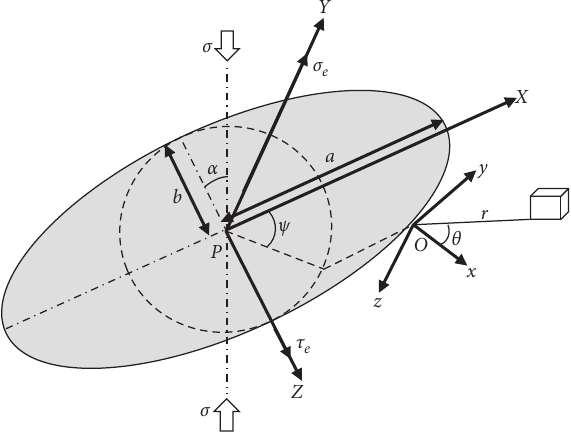
Figure 5: The 3D coordinate diagram of elliptic crack. Table 3: Specific parameters of 3D crack initiation calculation.